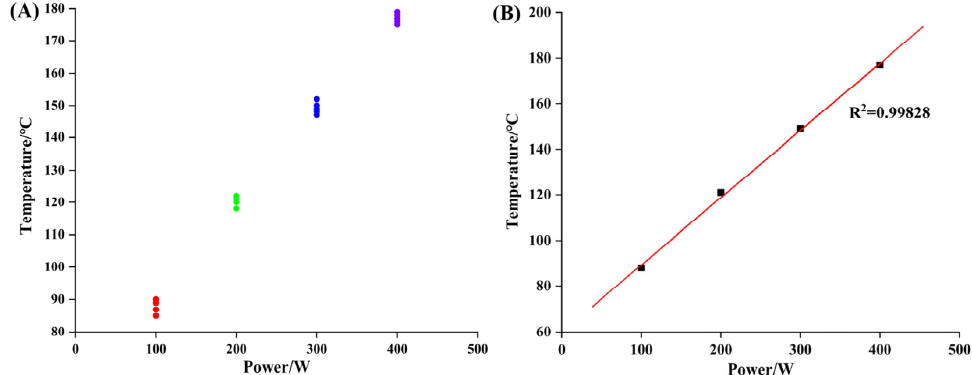
Figure 2. Relation between working power and its corresponding temperature in the ashing chamber. ( A ) The red, green, blue and purple circles are the value of temperatures monitored at 100 W, 200 W, 300 W and 400 W, respectively. ( B ) The black squares are the averages of the temperatures.